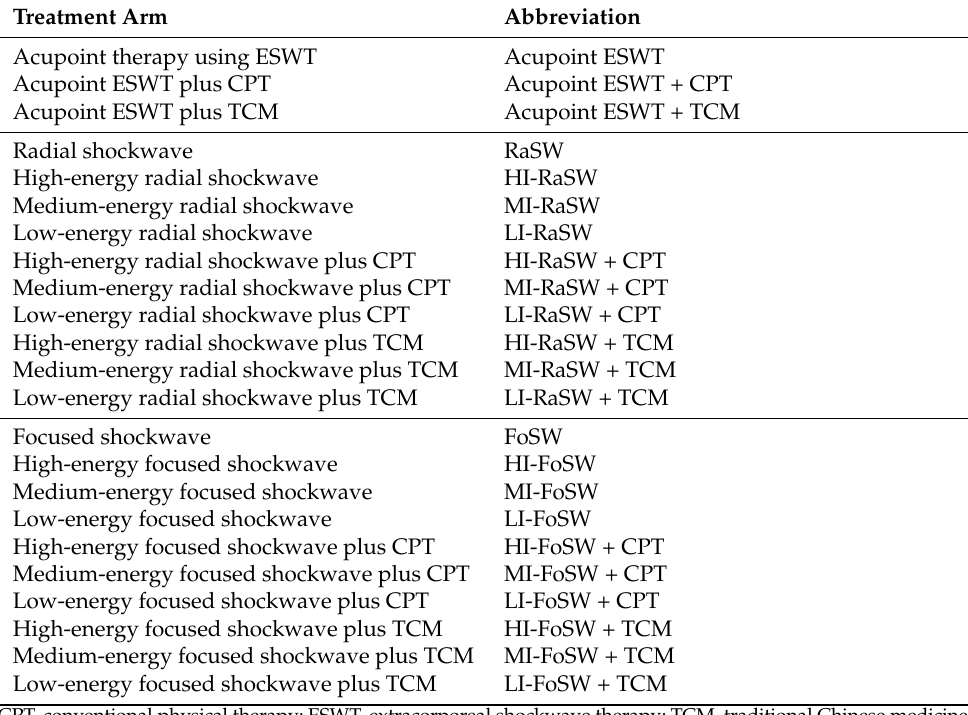
Table 3. Abbreviations for treatment